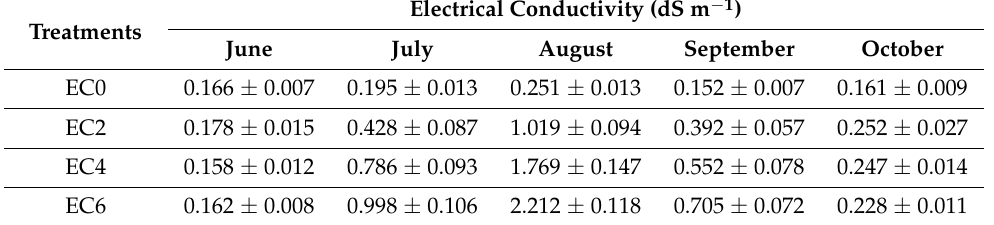
Table 1. Pattern of soil electrical conductivity (dS m − 1 ) through the hemp cycle in relation to saline water treatments (EC0 = non-saline water; EC2 = water at 2.0 dS m − 1 ; EC4 = water at 4.0 dS m − 1 ; EC6 = water at 6.0 dS m − 1 ).